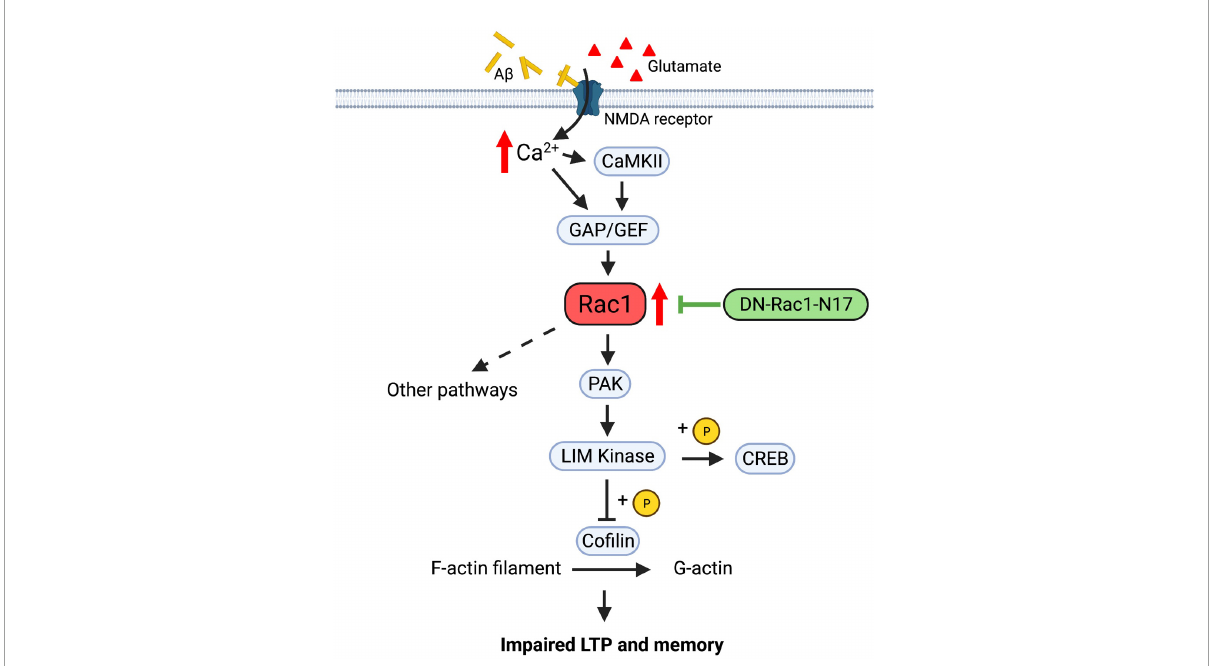
FIGURE9 Regulation of LTP and memory by Rac1 in APP mice. In normal animals, Ca 2 + influx from NMDA receptors activates Rac1 and multiple downstream signaling processes, including PAK-LIMK-cofilin pathway, to modulate actin reorganization, AMPA receptor trafficking and LTP expression. In APP mice, accumulation of A β peptides may lead to abnormal activation of NMDA receptors and hyperactive Rac1, which causes dysregulations of downstream proteins, including PAK, LIMK and cofilin, to impair LTP and memory. Expression of Rac1-N17 in hippocampal neurons reduces Rac1 activity and restores the function of some of its downstream proteins such as PAKs, thus improving LTP and memory in APP